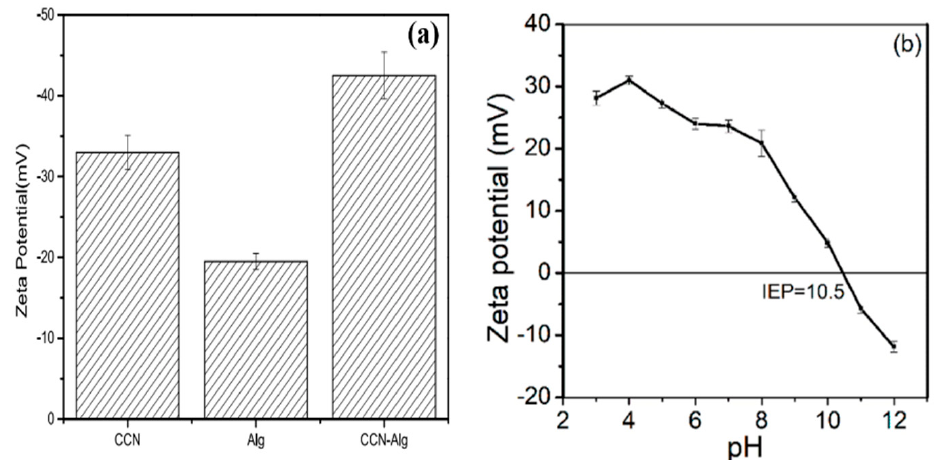
Figure 11. ( a ) Zeta potential (mV) of CCN, Alg, and CCN/Alg hydrogel beads. (Reprinted from Ref. [156], with permission from Elsevier), and ( b ) zeta potential of hydrogel beads varies as a function of pH, showing that negatively charged selenium absorbs at lower pH. (Reprinted from Ref. [167]. Copyright 2022 American Chemical Society).